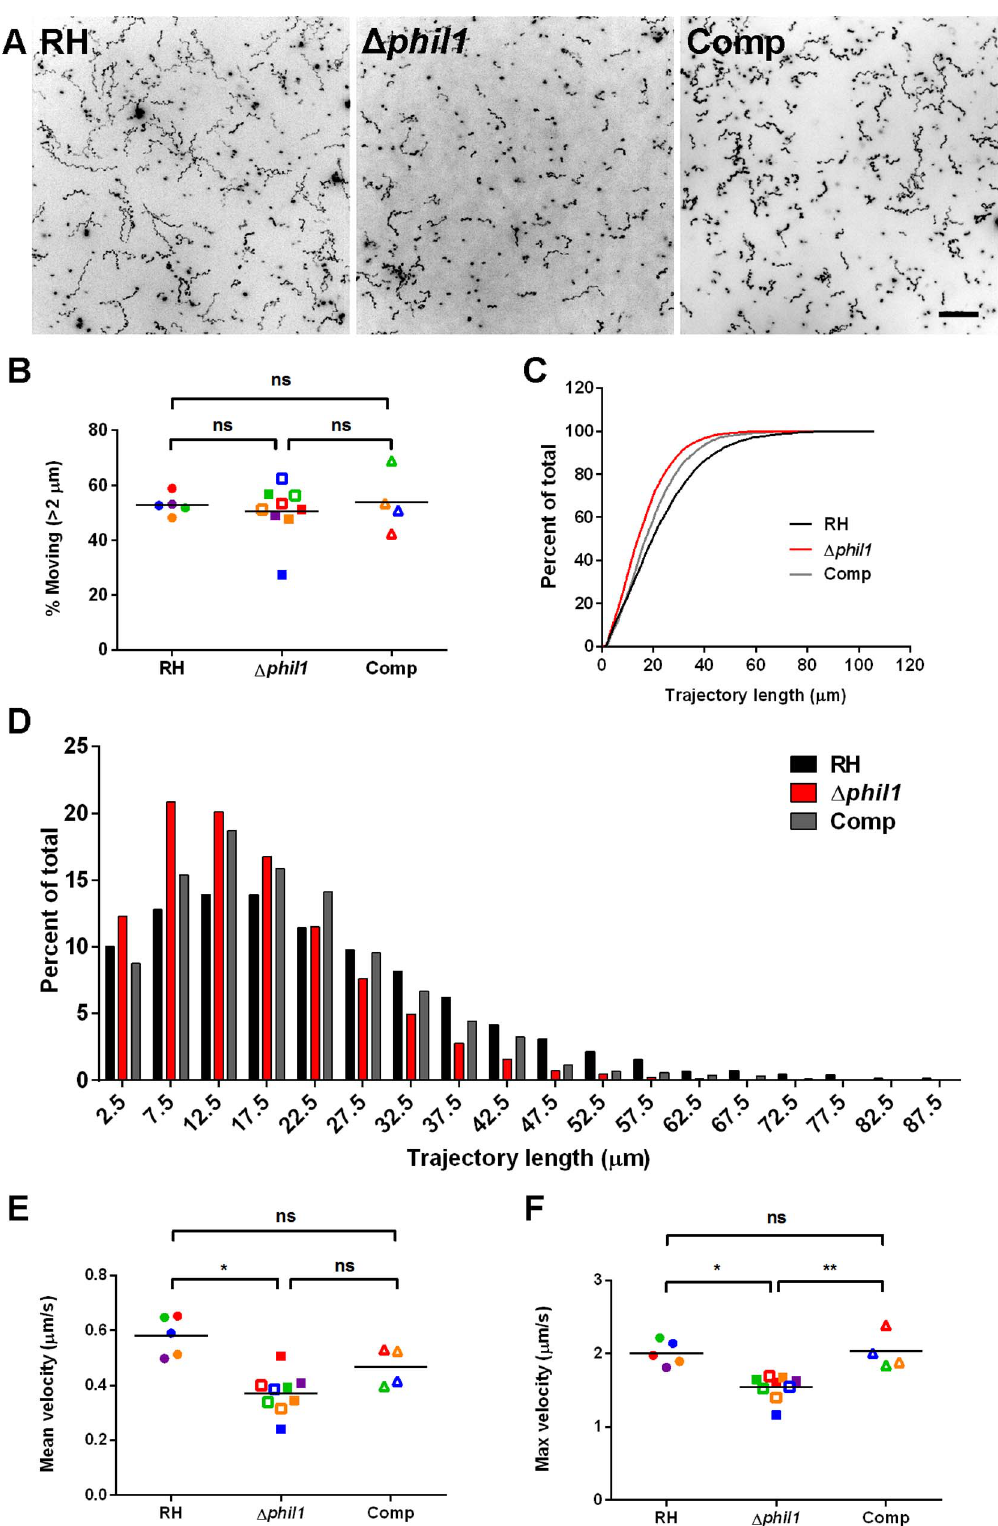
Figure 3. 3D motility of the D phil1 parasites. ( A ) MIPs for wild-type (RH), TgPHIL1 knockout ( D phil1 ) and complemented (Comp) parasites. Scale bar=50 m m. The colour scheme for all MIPs was inverted for better visualization of parasite trajectories. The percentage of total parasites moving ( B ) was comparable for the three parasite lines, but the cumulative frequency distribution ( C ) and histogram ( D ) of the smoothed trajectory lengths for RH (black), D phil1 (red) and Comp parasites (grey) reveal that the D phil1 parasites do not move as far as the RH or Comp parasites within the same timeframe (Kolmogorov-Smirnov test, D=0.199, p , 0.0001 and D=0.114, p , 0.0001, respectively). The D phil1 parasites also exhibited significantly